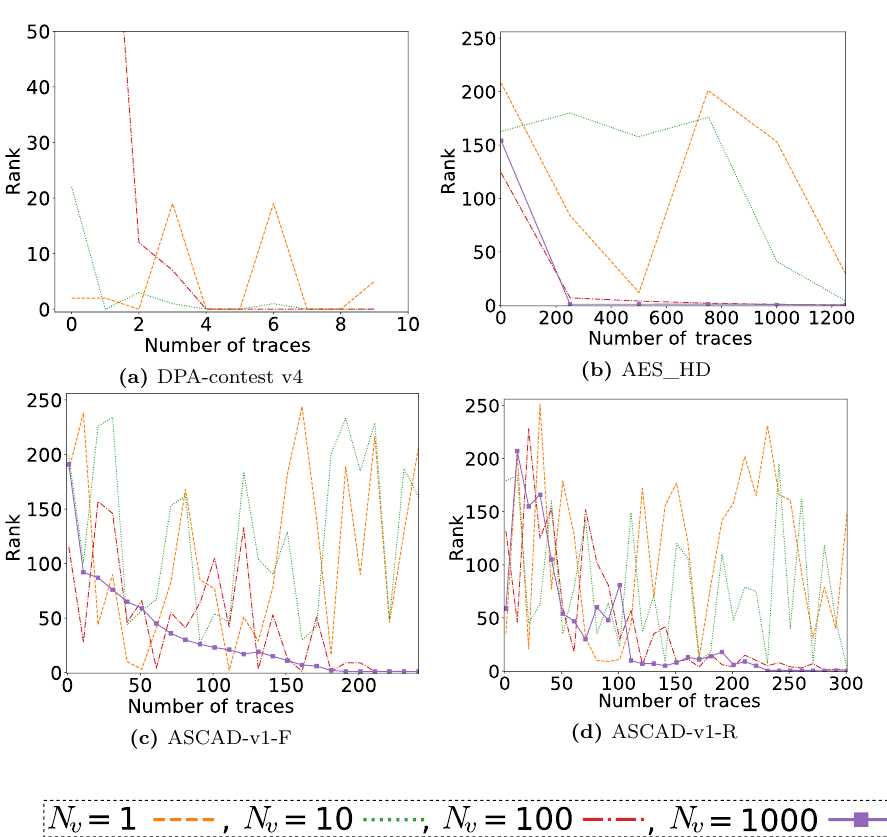
Figure 5: Mean rank evolution for cVAE-SA models depending on the number of latent representation N v